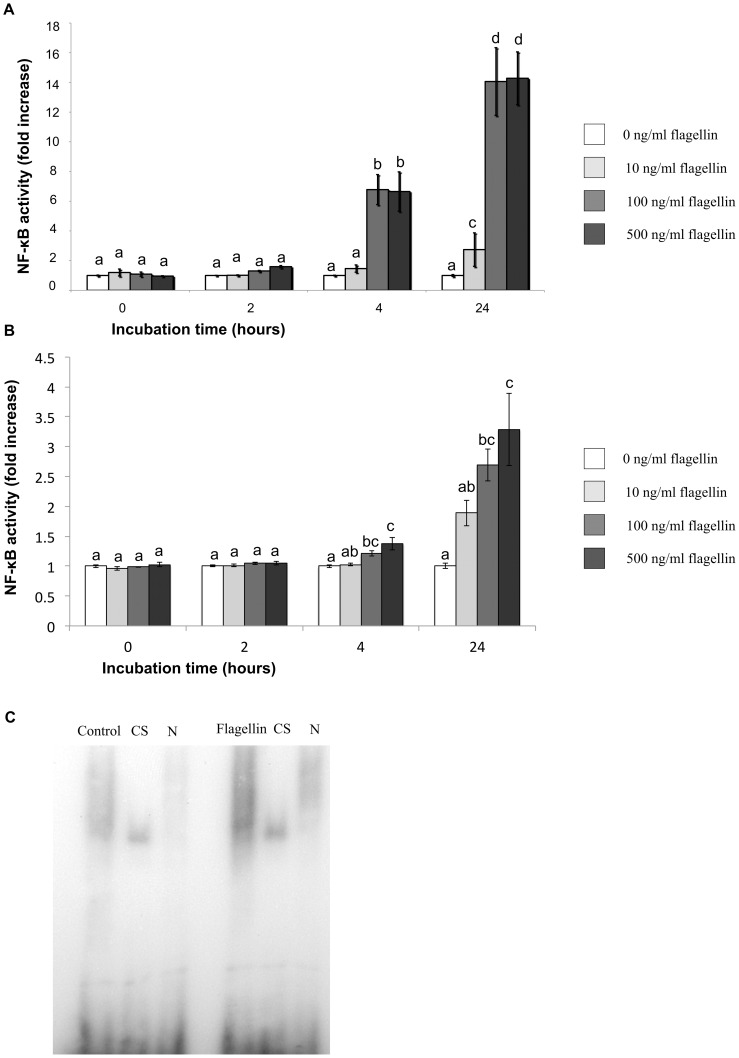
Effect of flagellin treatment on hTERT-EECs NF-κB activity.(A) hTERT-EECs and (B) Ishikawa 3-H-12 cells transfected with the SEAP reporter gene were co-cultured with 0, 10, 100 or 500 ng/ml of flagellin for 24 hours. Samples were collected at 0, 2, 4 and 24 hours and analyzed using Quantiblue™. Data of NF-κB activity are reported as the fold induction of SEAP activity over untreated controls. Different letters mean significant difference (p<0.05). (C) Electrophoretic mobility shift assays (EMSA) analysis of DNA-binding activity of NF-κB in hTERT-EECs treated with (flagellin group) or without (control group) 100 ng/ml of flagellin for 24 hours. Control reactions were incubated with either excess (1000 fold) unlabeled κB (cold specific; CS) or nonspecific cold probe (N) before reaction with labeled NF-κB probe.